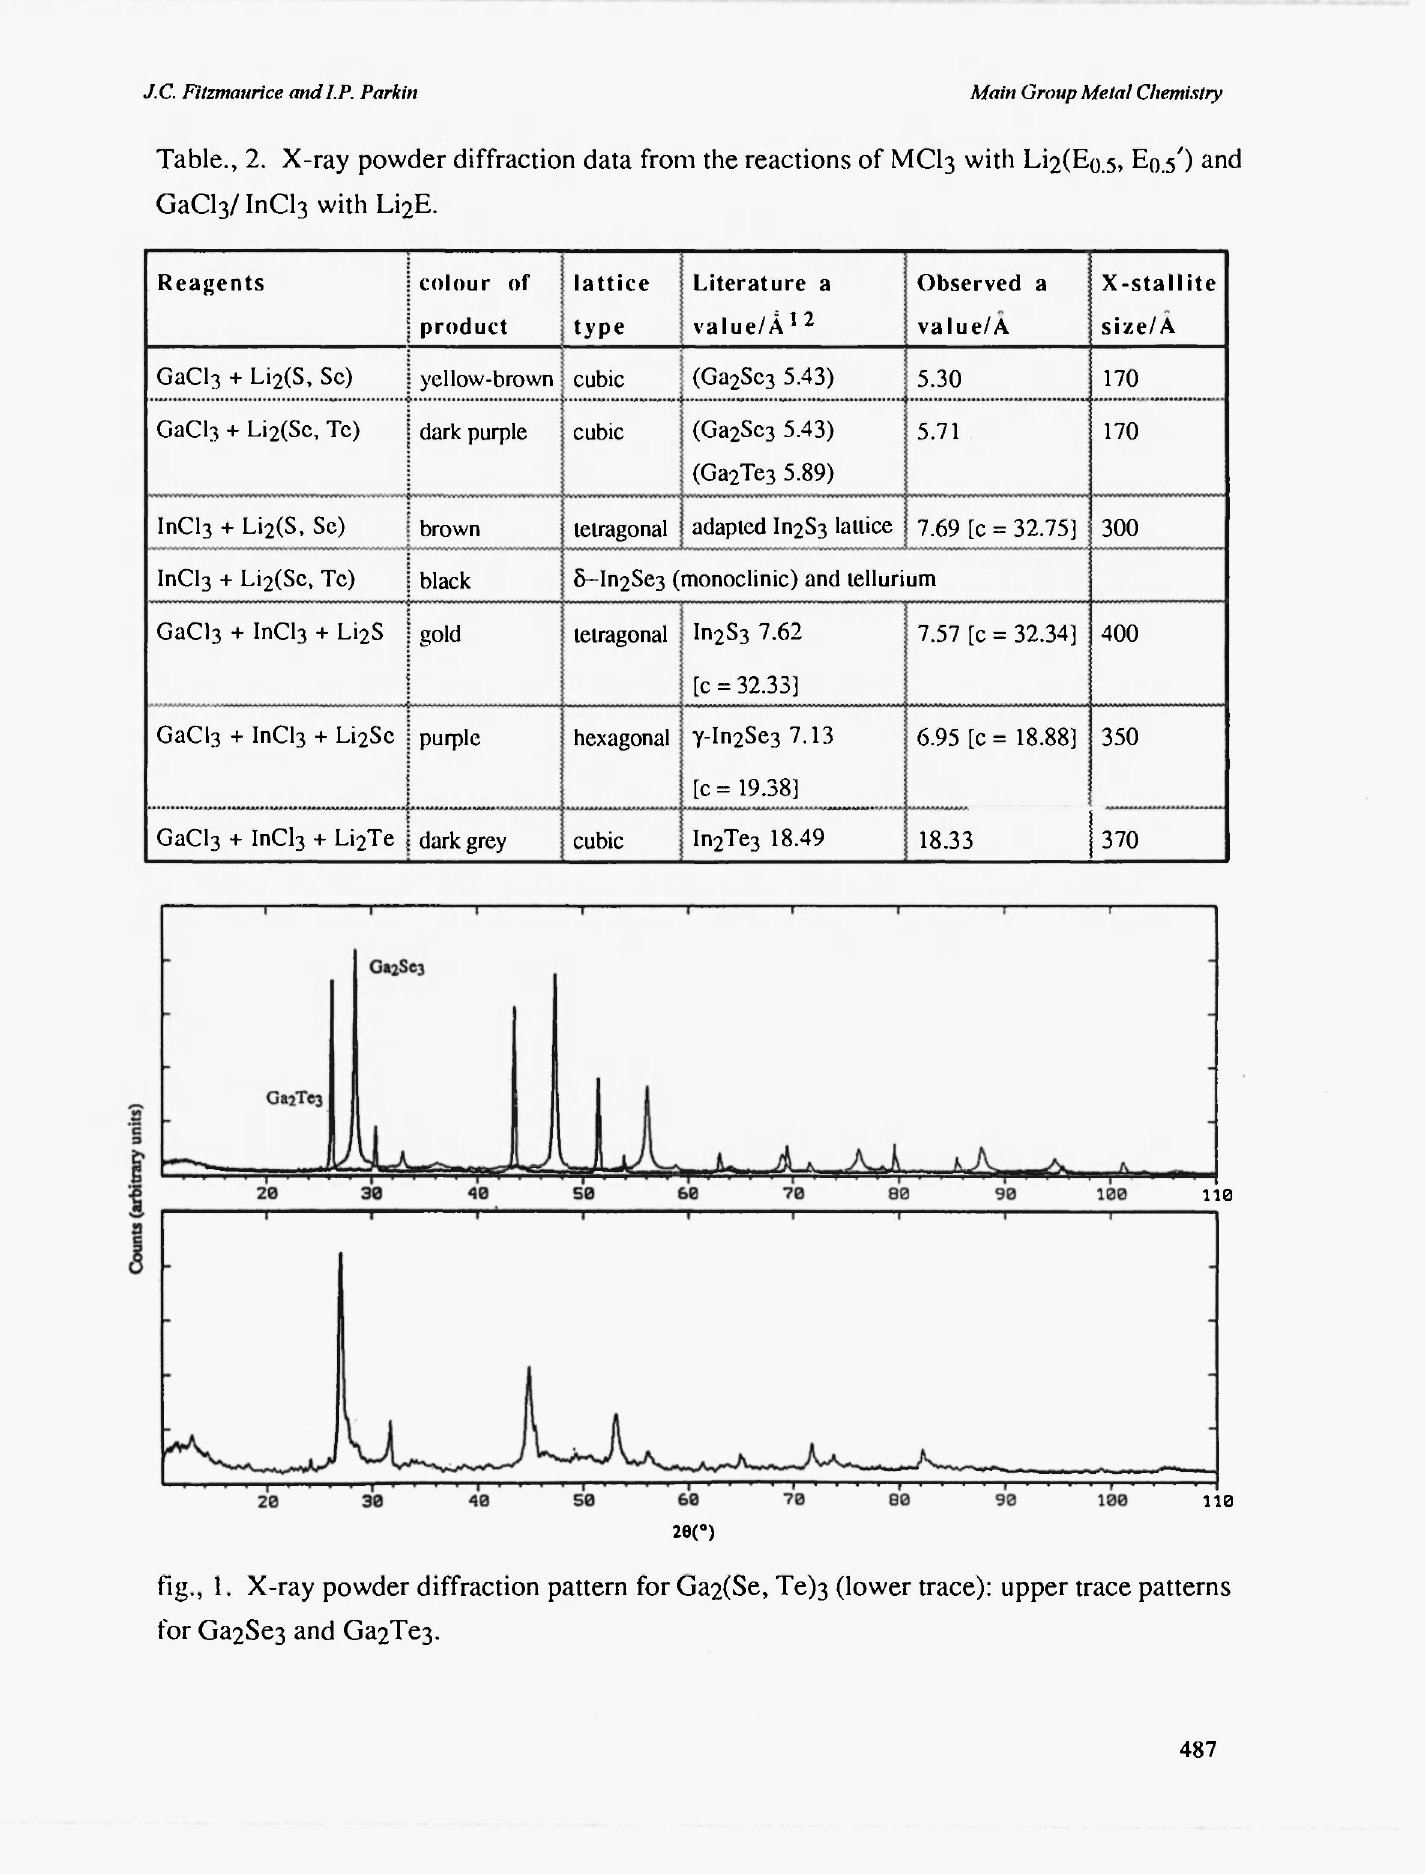
fig., 1. X-ray powder diffraction pattern for Ga2(Se, Te)3 (lower trace): upper trace patterns for Ga2Se3 and